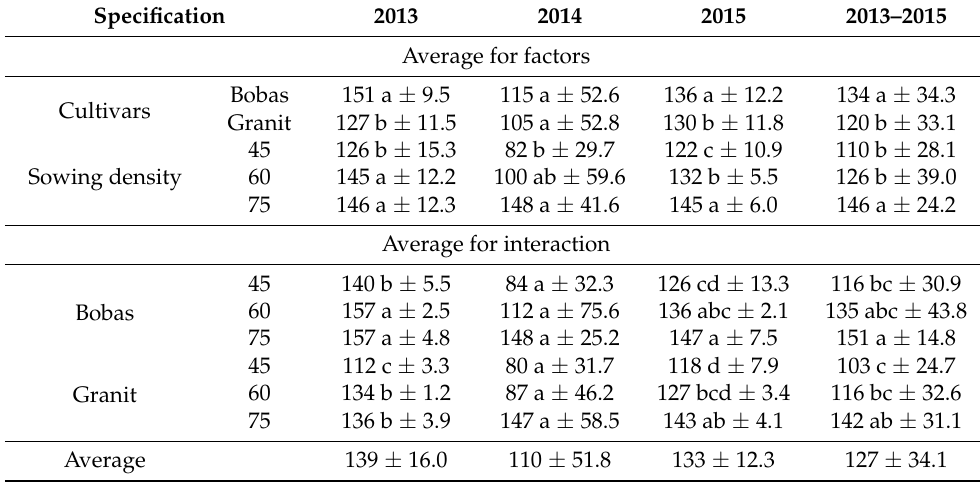
Table 4. Nitrogen accumulation in the faba bean seeds (kg ha − 1 ) as influenced by the examined factors during the study years 2013–2015.